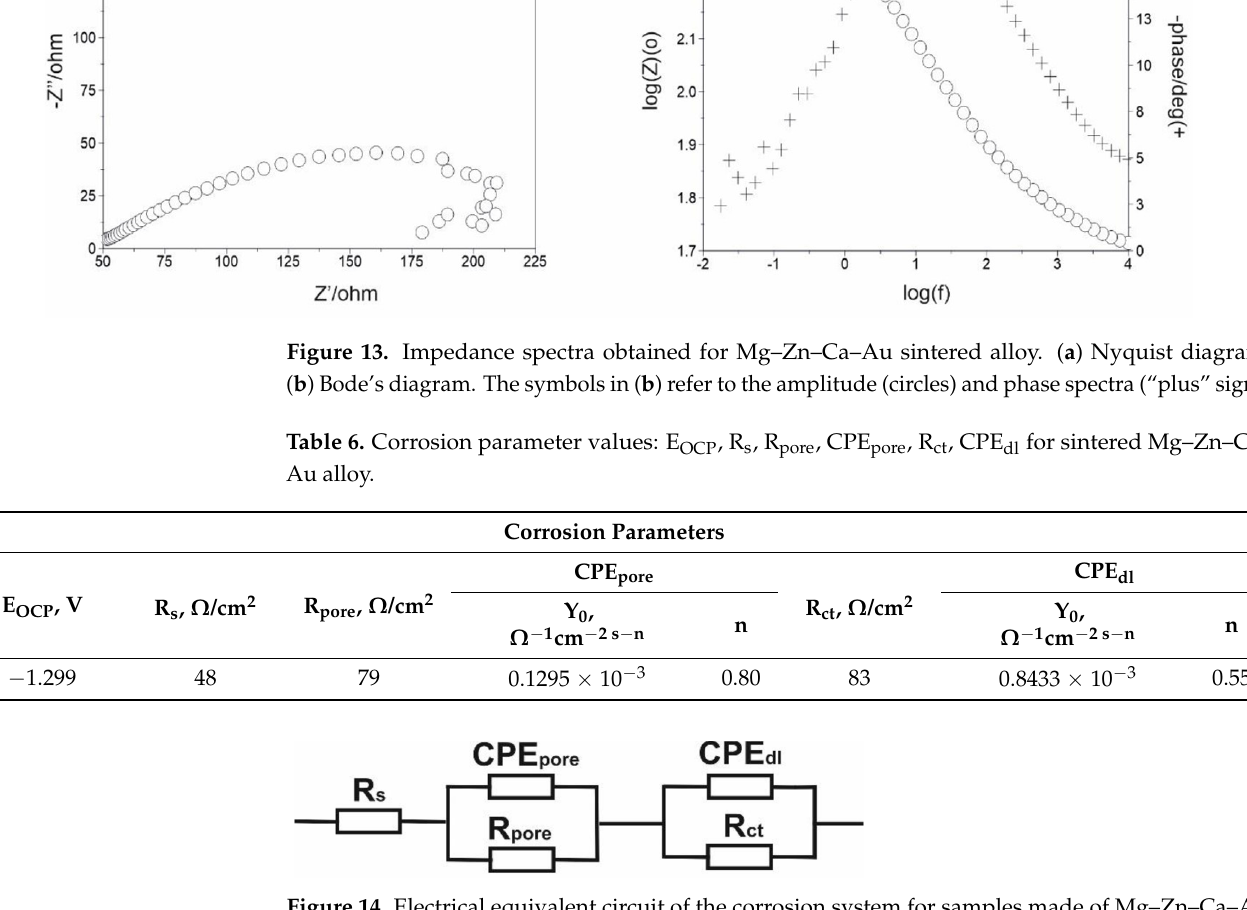
Figure 14. Electrical equivalent circuit of the corrosion system for samples made of Mg–Zn–Ca–Au sintered alloy.